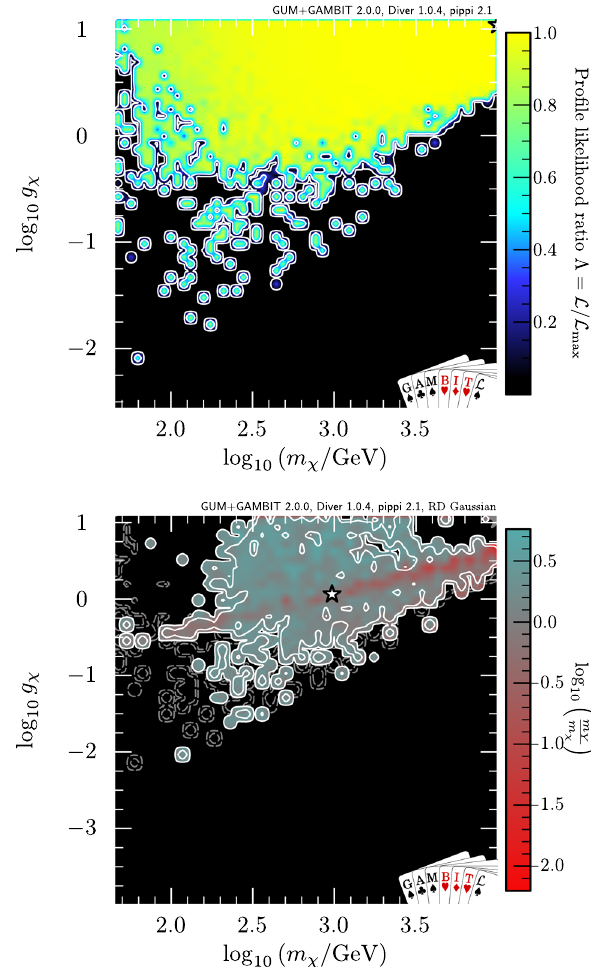
Fig. 3 Upper panel: profile likelihood in the m χ – g χ plane when the relicdensityisanupperbound. Lowerpanel:the m χ – g χ planecoloured by m Y / m χ , when treating the relic density as an observation. Shading and white contour lines represent 1 and 2 σ confidence regions. Grey contours in the lower panel are the 1 and 2 σ regions from the upper panel, where the relic density is used as an upper bound. The white star corresponds to the best-fit